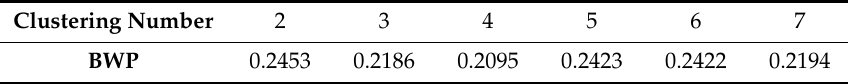
Table 4. BWP index of Z 3 with different number of clusters. Clustering Number